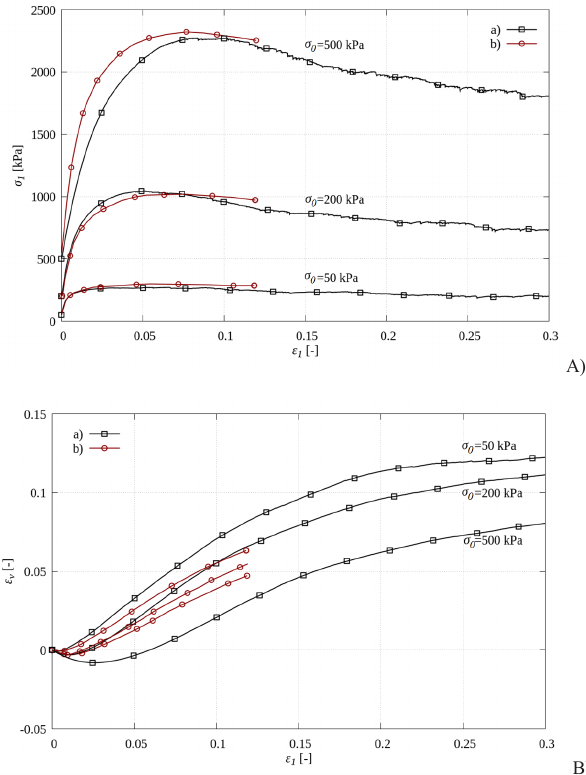
Figure 4: Discrete simulations of homogeneous triaxial compression test compared to experiments by Wu [1]: A) vertical normal stress σ and B) volumetric strain ε 1 numerical results and b) experimental results ( e mm, σ = 50, 200 and 500 0